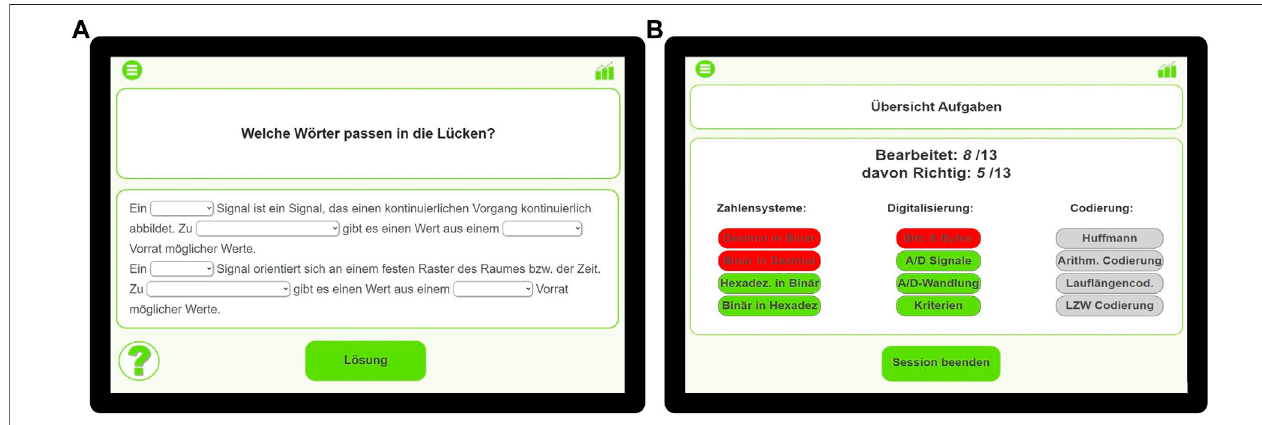
FIGURE 1 | Exemplary pages of the learning environment. Left: example exercise. Right: exercise